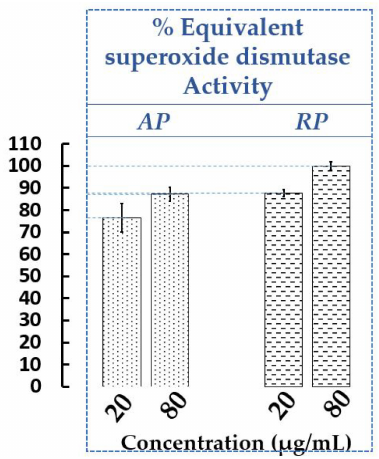
Figure 1. Equivalent SOD activity of AP and RP extracts of P. cuspidatum from Savoie Mont Blanc. n = 3 independent experiments for each concentration ( µ g/mL). Bars depict ±